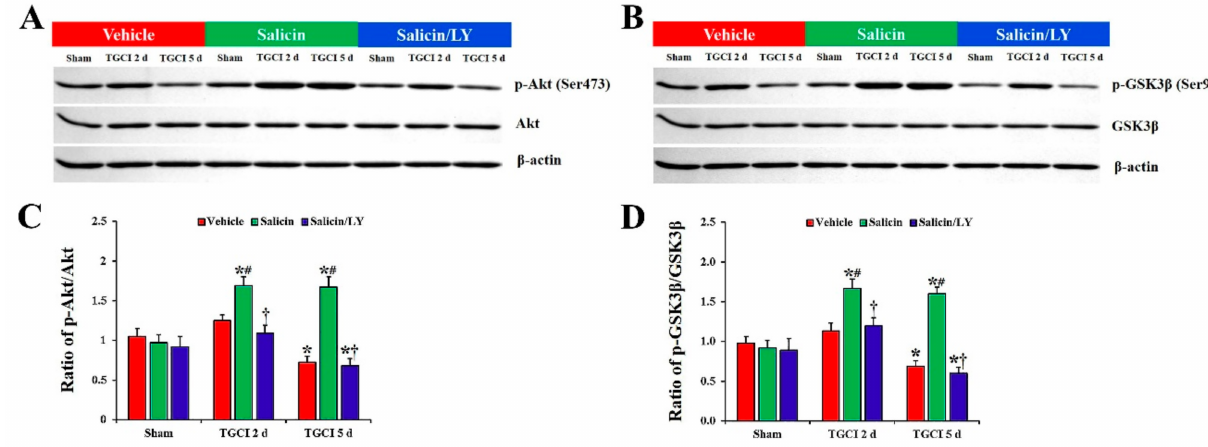
Figure 8. ( A , B ) Western blot images of p-Akt, Akt, p-GSK3 β , and GSK3 β in CA1 of the vehicle-treated, salicin-treated, and salicin/LY-treated groups at sham, 2 days, and 5 days after TI. In the salicin-TI group, the ratios of p-Akt/Akt and p-GSK3 β /GSK3 β are significantly higher than those in the vehicle-TI group. Whereas, in the salicin/LY-TI group, the ratios of p-Akt/Akt and p-GSK3 β /GSK3 β are similar to those in the vehicle-TI group. ( C , D ) Quantitative analysis of the levels of p-Akt and p-GSK3 β by normalization to the levels of Akt and GSK3 β , respectively. The bars indicate the means ± SEM ( n = 5 at each time, * p < 0.05 vs. each sham group, # p < 0.05 vs. vehicle-TI group, † p < 0.05 vs. salicin-TI group; the vehicle-sham group was regarded as control